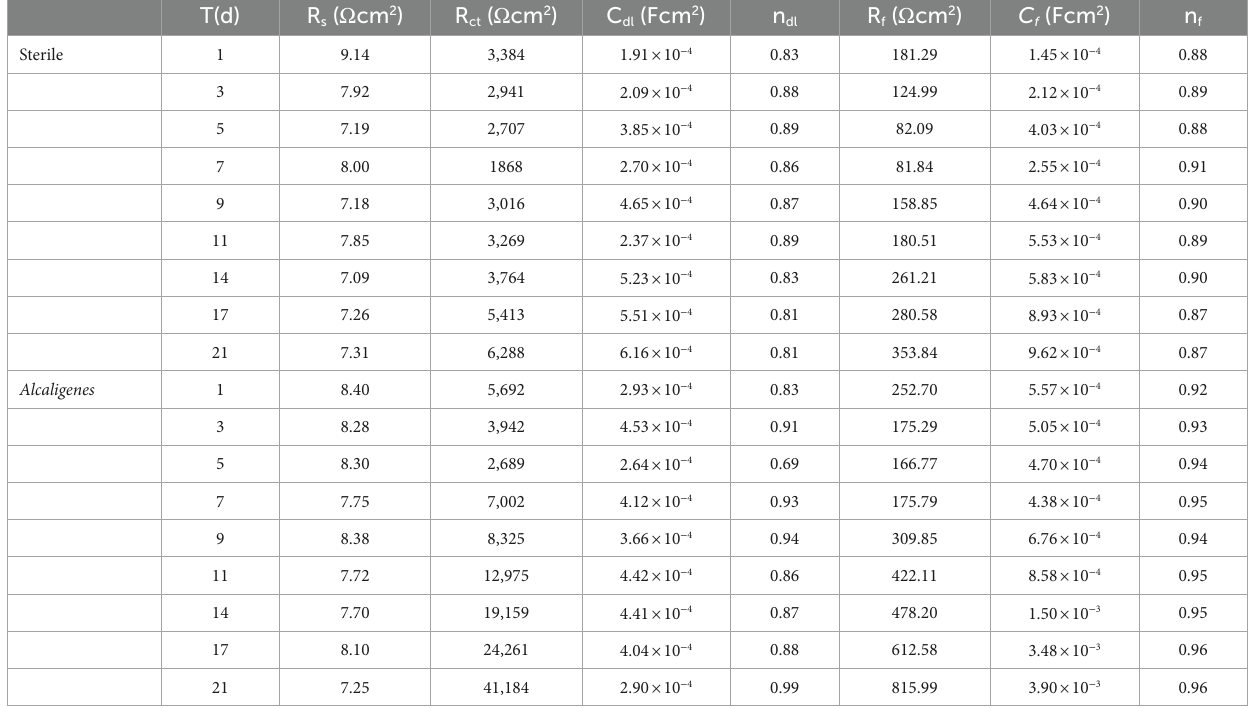
TABLE 1 AC impedance spectrum fitting parameters for X65 steel in different